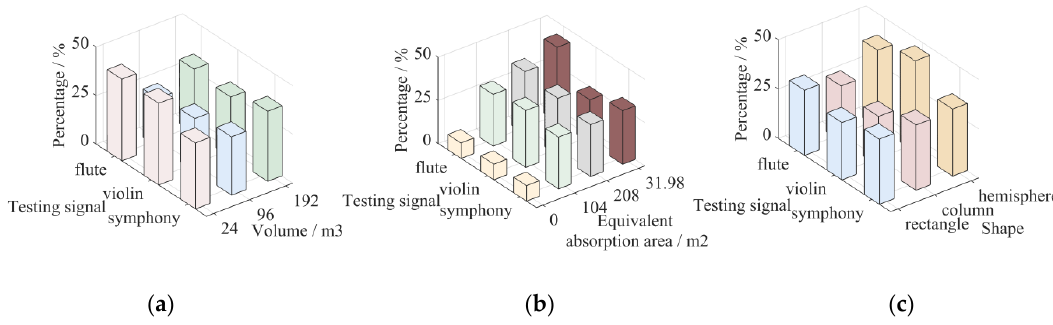
Figure 9. The sound perception changes caused by closed space parameters of ( a ) space volume, ( b ) wall surface sound absorption coefficient, and ( c ) space shape when the position of the receiving point is not considered. The x, y, and z axes represent the parameter change, the testing audio, and the corresponding percentage of the times being selected, respectively; the higher the percentage, the better the auditory perception.